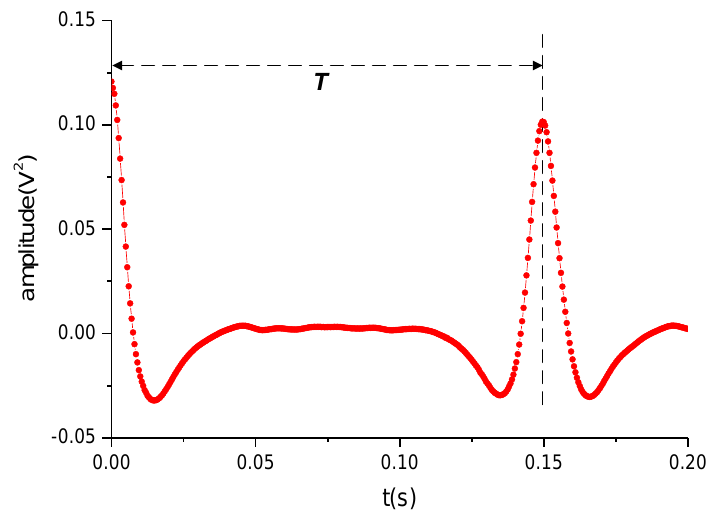
Figure 19. ( a ) Signal collected at the rotational speed of 400 rpm. ( b ) Auto-correlation of the signal.